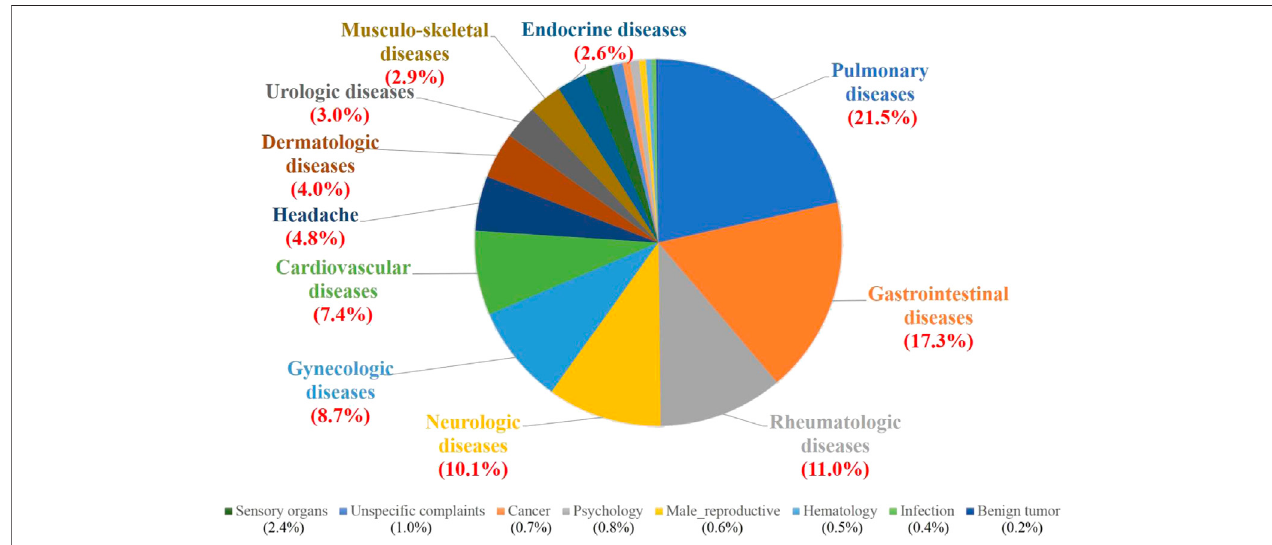
FIGURE 2 | Clinical indications of prescriptions of Fuzi and Fuzi-based formulas from TCM doctors in systematic categories. The percentage of total Fuzi-related prescription numbers for indicated diseases is shown in parentheses.